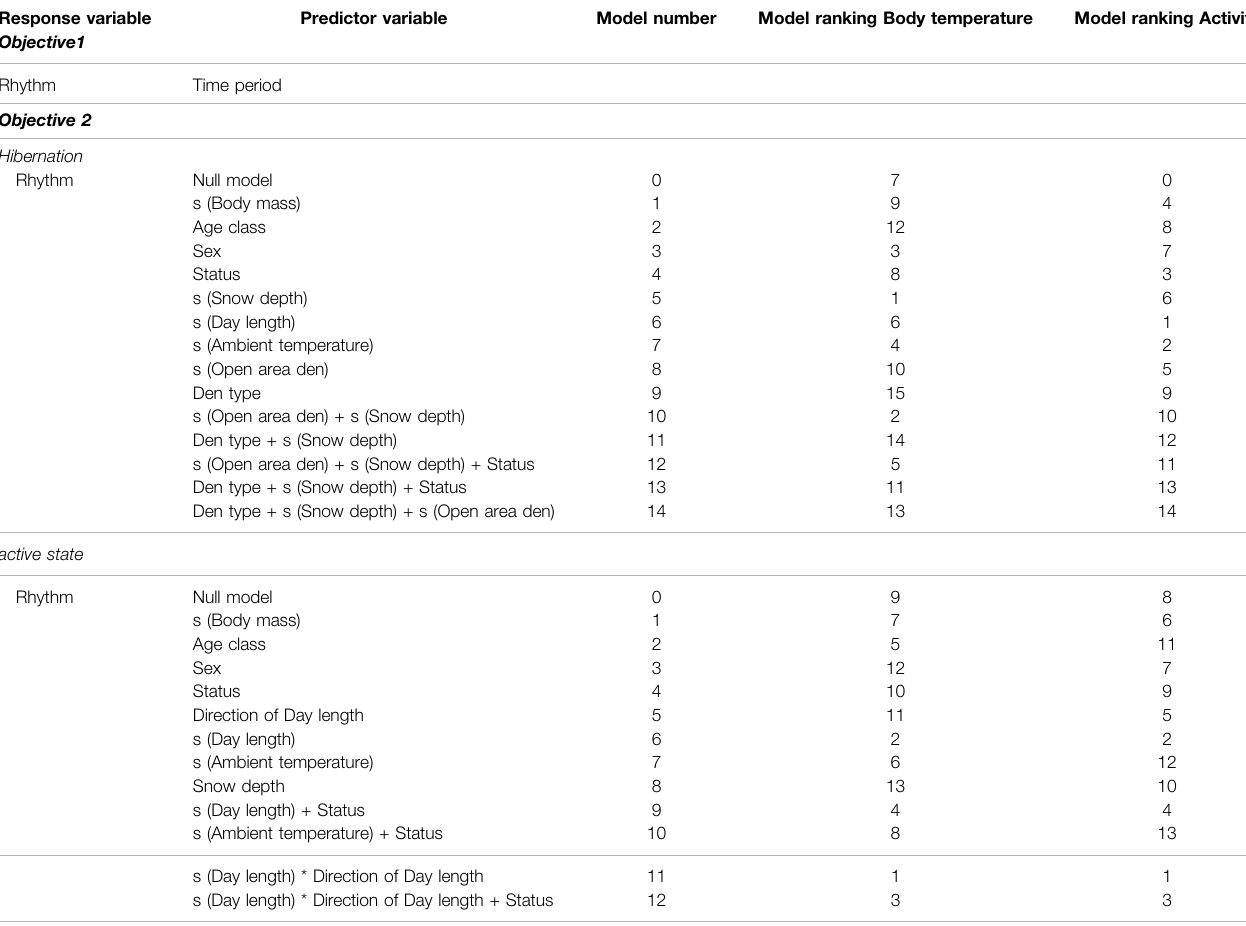
TABLE2| Setofaprioricandidatemodelsandmodelrankingbasedon SupplementaryTablesS3-S6 forObjective1and2forT b ,activityandHRdatasets.Allmodelsfor Objective 1 were fi t with a group-level effect for the individual Bear ID. All models for Objective 2 were fi t with a group-level effect for the individual Bear and